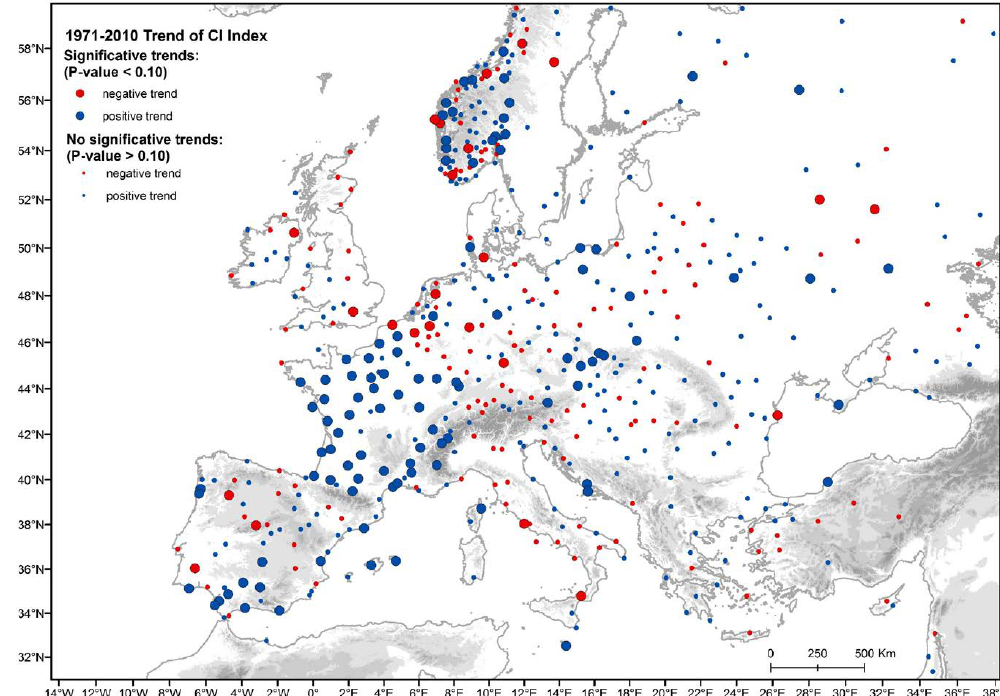
Fig. 12. Autumn CI trend distribution (1971–2010). Positive trends are in blue and negative ones in red. Large dots represent significative trends ( p < 0 . 10), otherwise small dots are